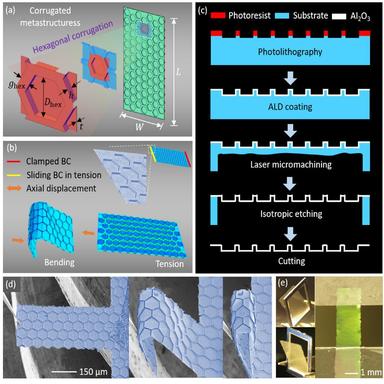
(a) Design principle of the nanoscale metastructures with hexagonal corrugation. (b) Numerical modelling of the corrugated metastructures and the bending and tensile deformation configurations of the metastructures under the axial compression and tension. (c) Nanoscale fabrication procedures of the nanoscale metastructures, including the photolithography, ALD coating, laser micromachining, isotropic etching, and cutting. (d) SEM images of the corrugated metastructures subjected to axial bending (L = 4 mm, W